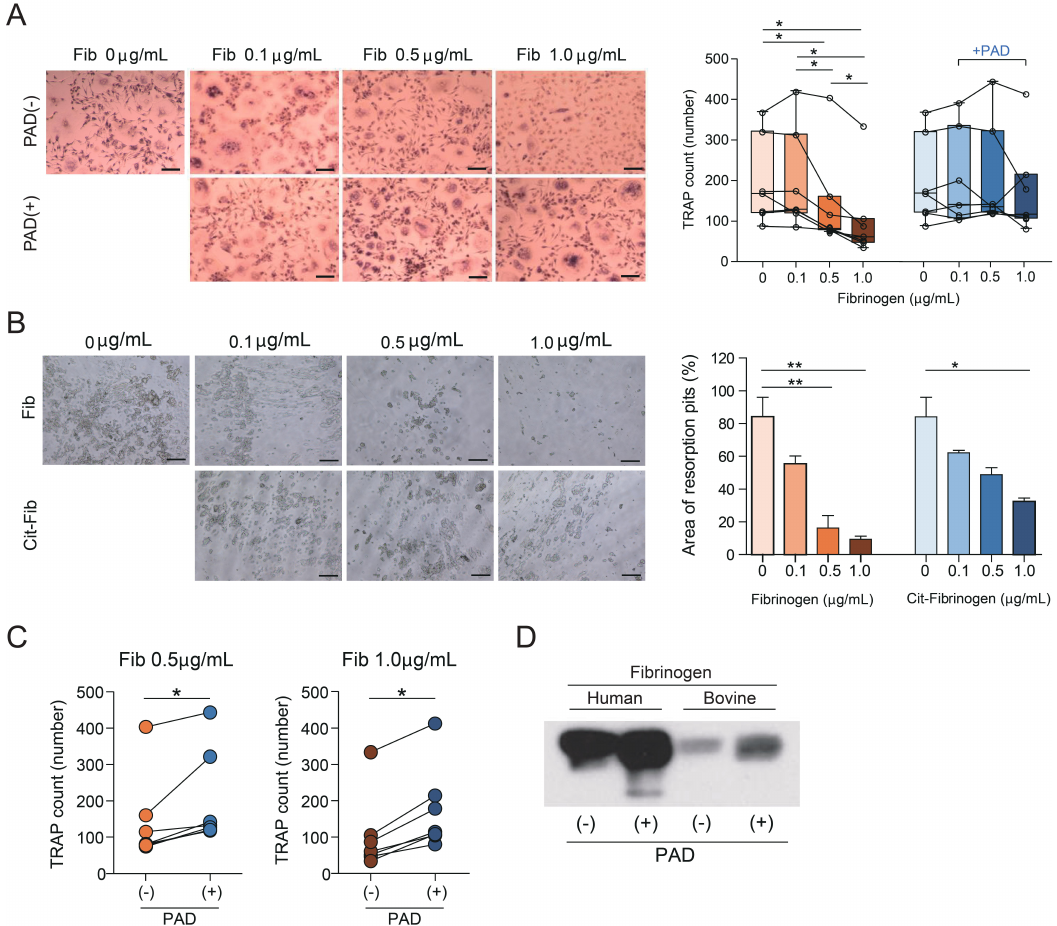
Figure 4. Reversion of dose-dependent inhibition of osteoclastogenesis in the presence of PAD. ( A ) Left: monocytes were cultured in the absence or presence of PAD2 (PAD) and stained for TRAP on day 6 ( n = 6). M-CSF (20 ng / mL) and RANKL (40 ng / mL) were replenished every 3 days. M-CSF and RANKL were supplemented in the control group. Fib = bovine fibrinogen. Scale bar 200 µ m. Right: number of TRAP-positive osteoclasts in the absence or presence of PAD. * p < 0.05. Individual values are plotted, and error bars represent SD. ( B ) Left: bone resorption activity in the presence of fibrinogen or citrullinated fibrinogen for 6 days. Fib = human fibrinogen, Cit-Fib = citrullinated human fibrinogen. Scale bar 100 µ m. Right: area of resorption pits (%). * p < 0.05; ** p < 0.01. ( C ) Number of TRAP-positive osteoclasts according to fibrinogen dose. * p < 0.05. Individual values are plotted. ( D ) Western blot using an antibody against citrullinated fibrinogen and protein from reaction mixtures containing PAD with human fibrinogen or bovine fibrinogen incubated at 37 ◦ C for 2